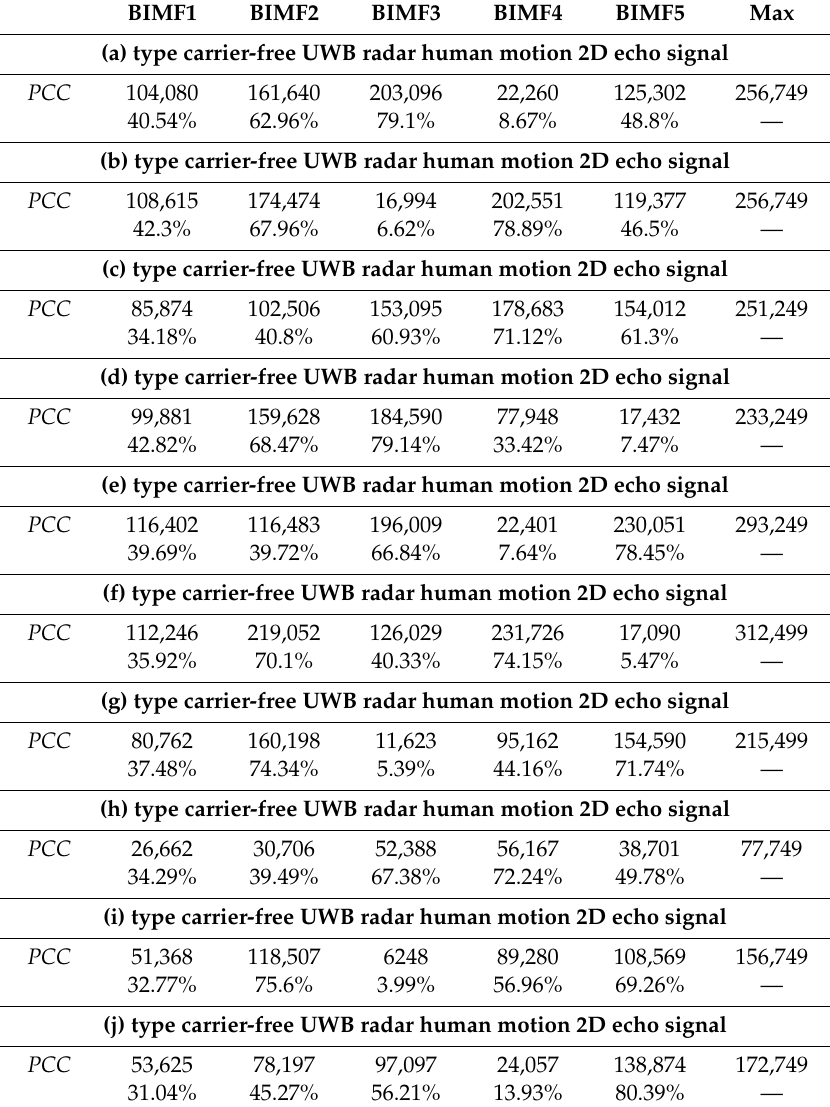
Table 4. The number and percentage of PCC about 2D signal and